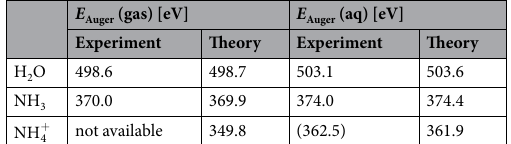
Table 1. Calculated and experimental energies of the leading (local) Auger peak for H 2 O, NH 3 and + NH gas phase and in aqueous solution. The calculated gas-phase values were obtained using the MOM-CCSD(T) method with cc-pCVTZ basis set for heavy atoms and cc-pVTZ basis set for hydrogen atoms. The solvent shift was calculated within a polarizable continuum model as described in the Methods, and has been used to determine the theoretical Auger energies for aqueous phase. The molecular geometries were optimized at the MP2/cc-pVTZ level. Experimental values for H 2 O and NH 3 are taken from refs 5 and 16, respectively. The value for + NH (aq) is from Fig. 4A (peak A ), and the bracket indicates that the peak assignment is assisted by 4 computations; see text for